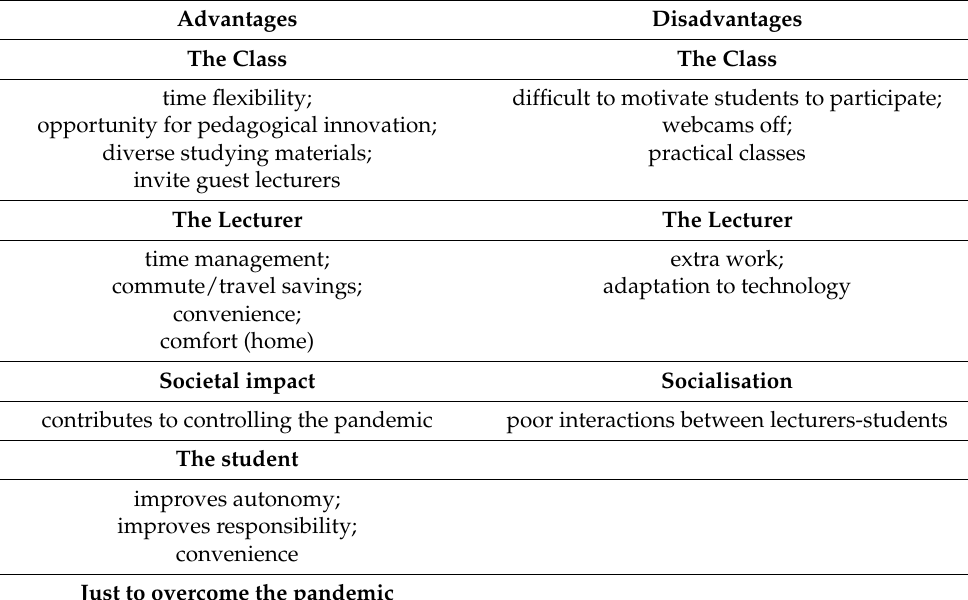
Table 5. Advantages and disadvantages of ERT: results of qualitative